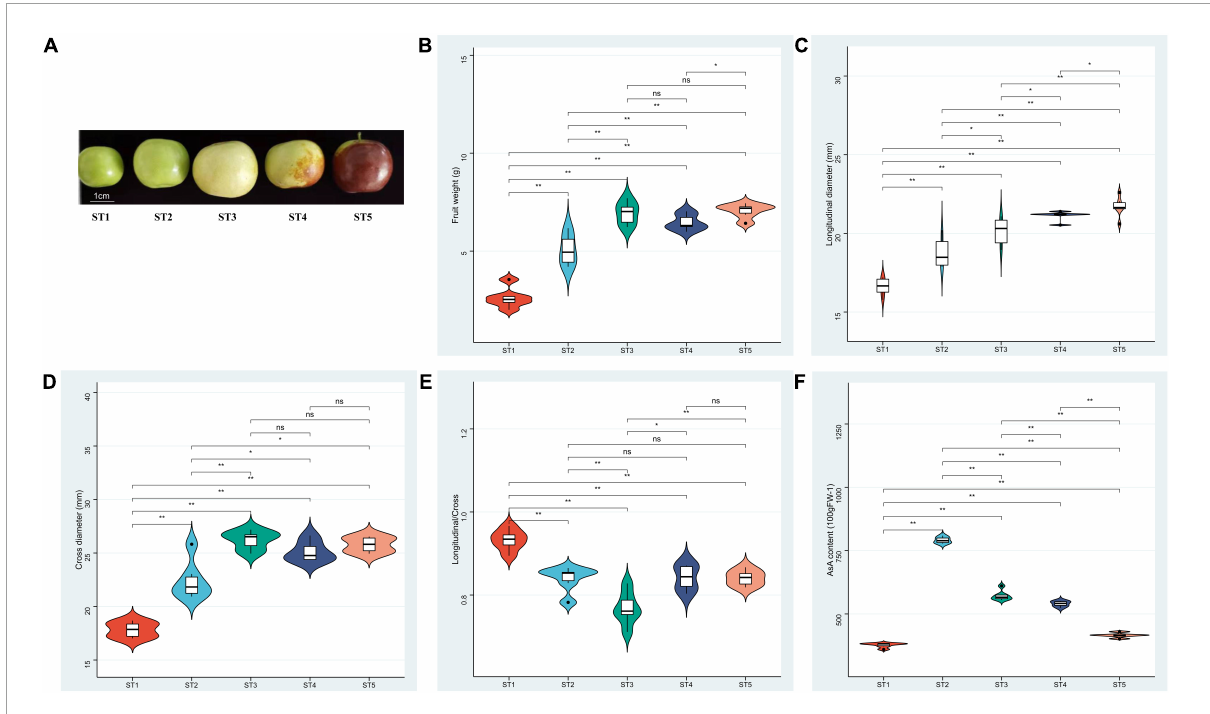
FIGURE1 Phenotype traits of “Mazao” from ST1 to ST5 stages. (A) Shape. (B) Fruit weight. (C) Longitudinal diameter. (D) Cross diameter (E) Longitudinal/Cross. (F) AsA content. The statistical analysis was determined using Ducan’s mutiple range test, * P < 0.05; ** P < 0.001; ns means Not